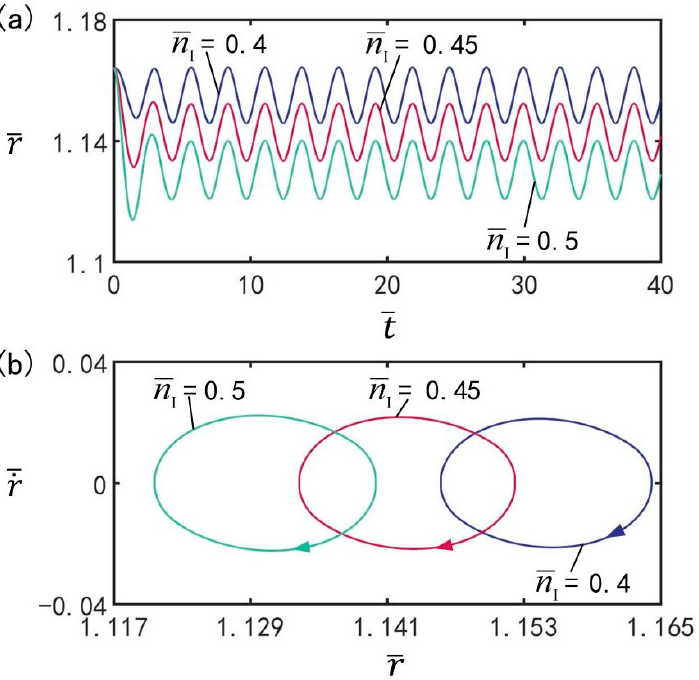
Figure 8. The effect of amount of gaseous substance n I on the beating of the LCE balloon. ( a ) Time